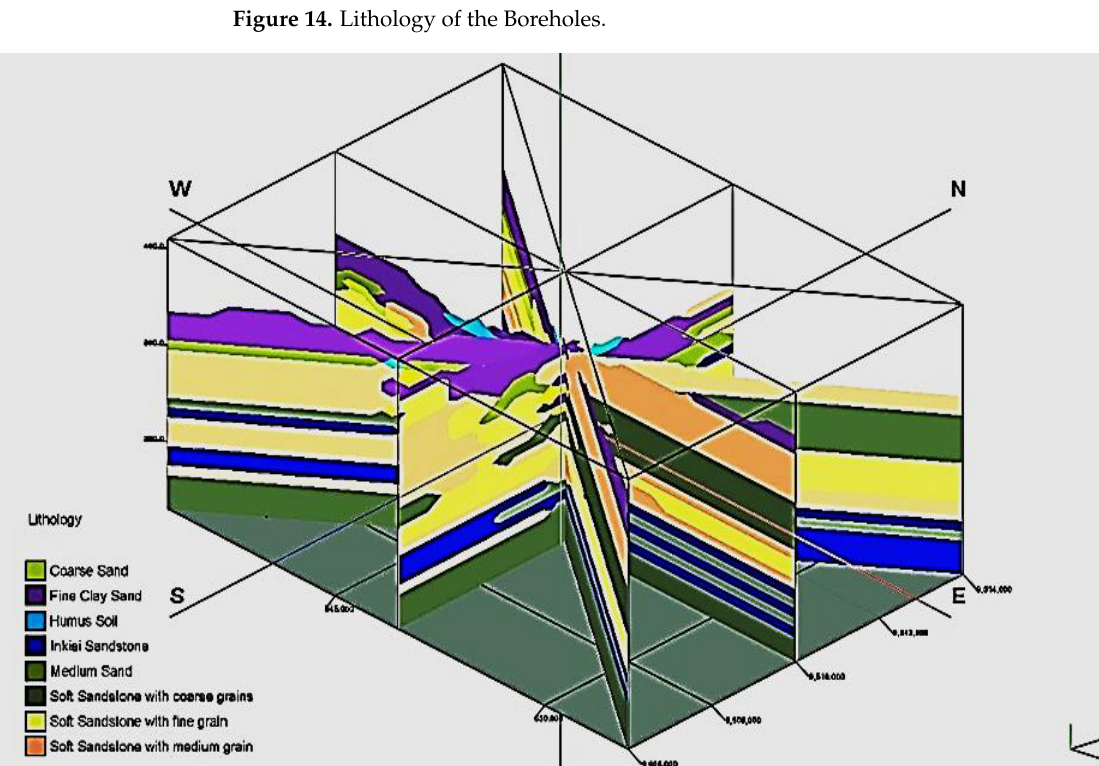
Figure 15. Lithology fence diagram.